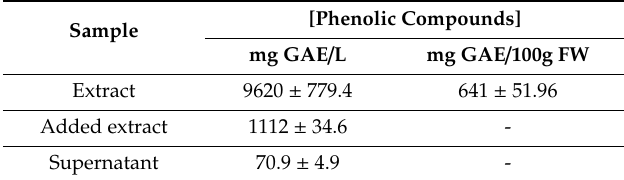
Table 1. The concentration of total PCs.